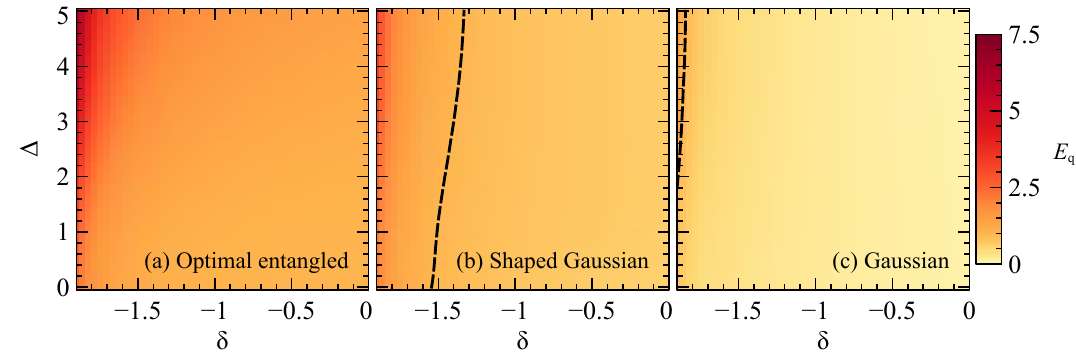
Figure 8: Comparison of the quantum enhancement E separable pulses (37), achievable via (a) the optimal entangled two-photon wave func- tion (15), (b) the unshaped Gaussian pulse of (69), and (c) the optimized Gaussian via the pulse shaping function of (73). For each ( δ , ∆ ) defining the matter response function (15), we attune the Gaussian pulse by setting its widths as σ = 3 γ ( 2 + ∆ ) (see text). The quadratic phase in (76) is φ = 1. On the left of the and ζ = γ e dashed line the various two-photon wave functions perform better ( E optimal separable pulses (37). Panel (a) reproduces the numerical results of [ 40 ]